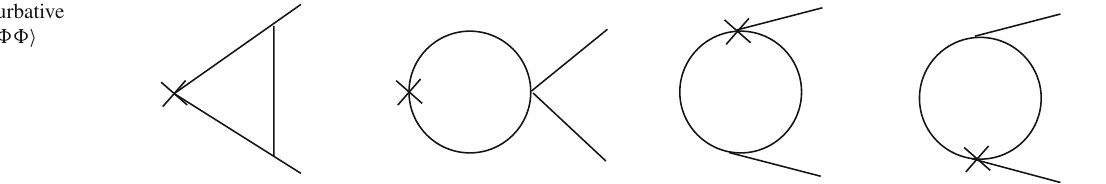
Fig. 5 1-Loop perturbative expansion of the (cid:2) T (cid:2)(cid:2) (cid:3)